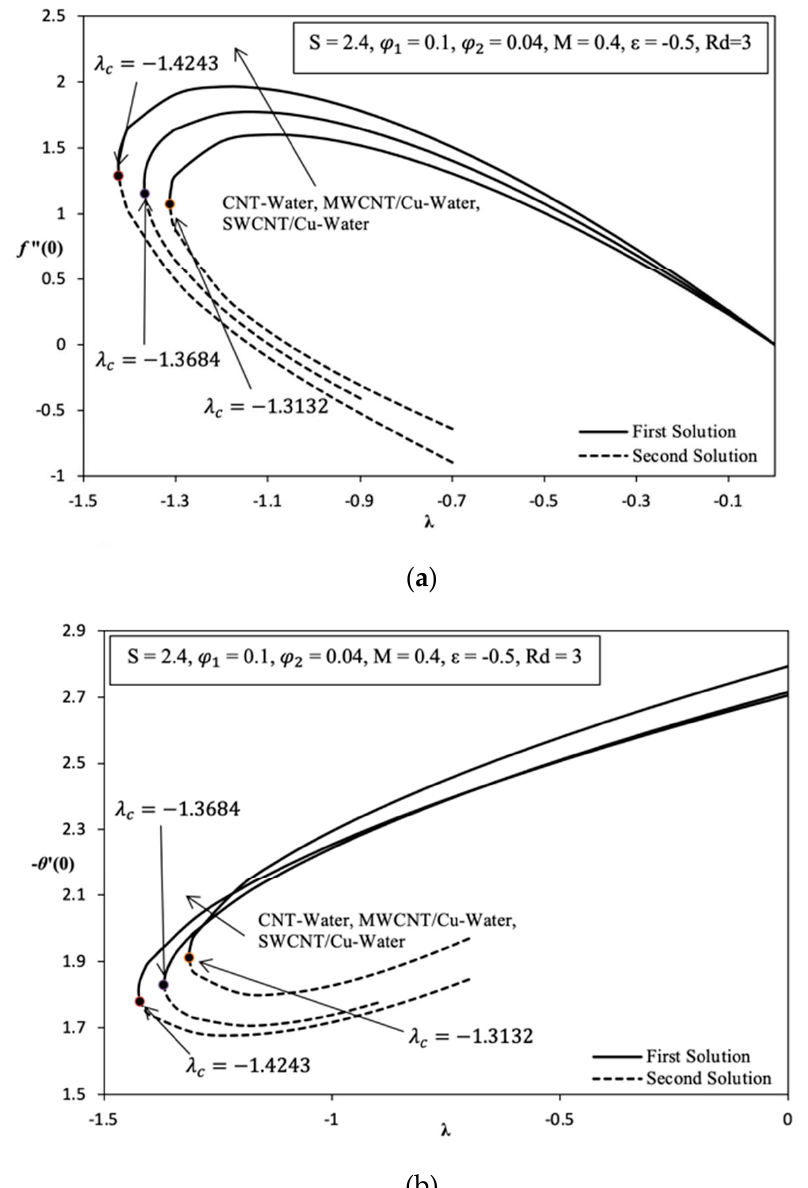
Figure 5. Variation versus λ with different nanofluid types when S = 2.4, ϕ 1 = 0.1, ϕ 2 = 0.04, M = 0.4, ε = − 0.5, Gr = 0, and Rd = 3: ( a ) variation on f ″ (0); ( b ) variation on − θ ′ (0).